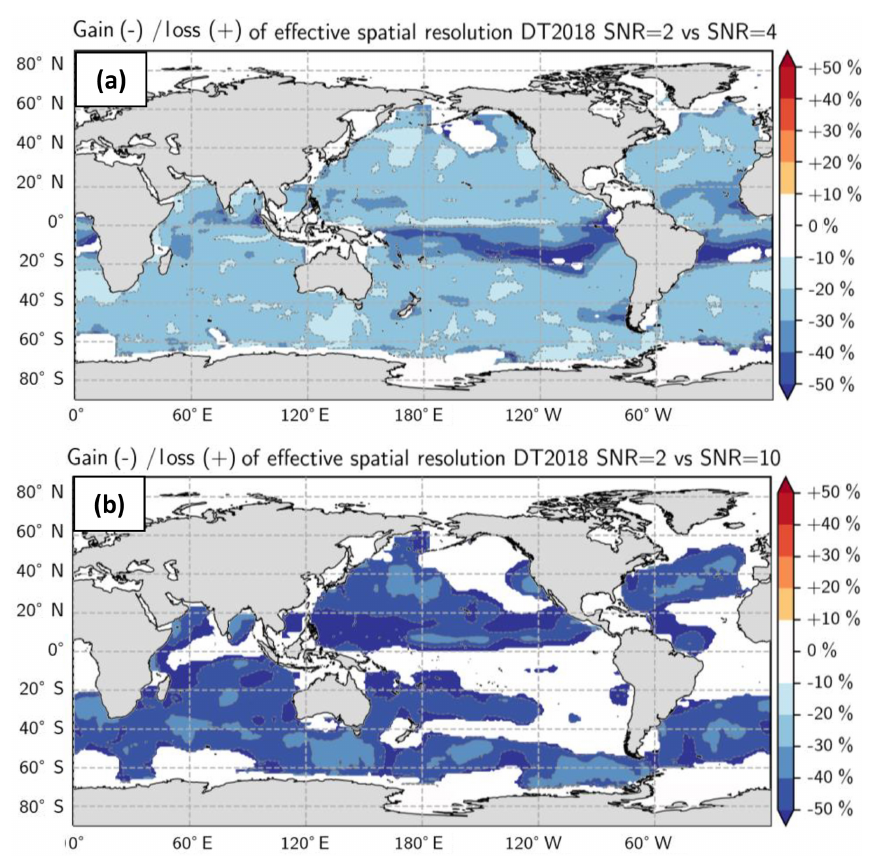
Figure B3. Ratio of effective resolution computed with (a) SNR = 2 vs. SNR = 4 criterion and (b) SNR = 2 vs. SNR = 10 criterion. Blue means finer resolution with SNR = 2. The white areas correspond to the regions where the SNR threshold criterion is not achieved.